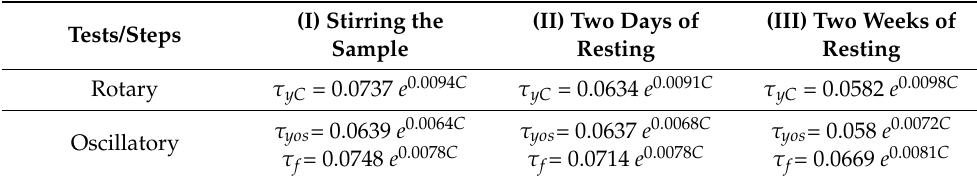
Figure 9. Yield and flow-point stress values versus sediment concentration in rotational and oscillatory tests. Table 8. Relationship of yield and flow-point stress values versus sediment concentration in both rotational and oscillatory tests for three steps.